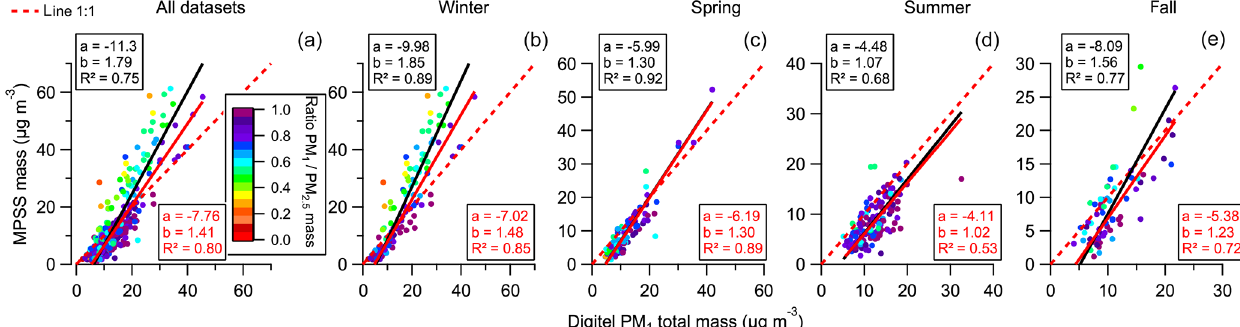
Figure 10. (a) Comparison between filter PM 1 total mass concentrations and the MPSS-derived mass concentrations for the entire period and (b–e) the different seasons. The black lines and boxes correspond to the regression fitting without threshold correction and the red lines to the regression fitting according to a PM 1 :PM 2 . 5 > 0 .